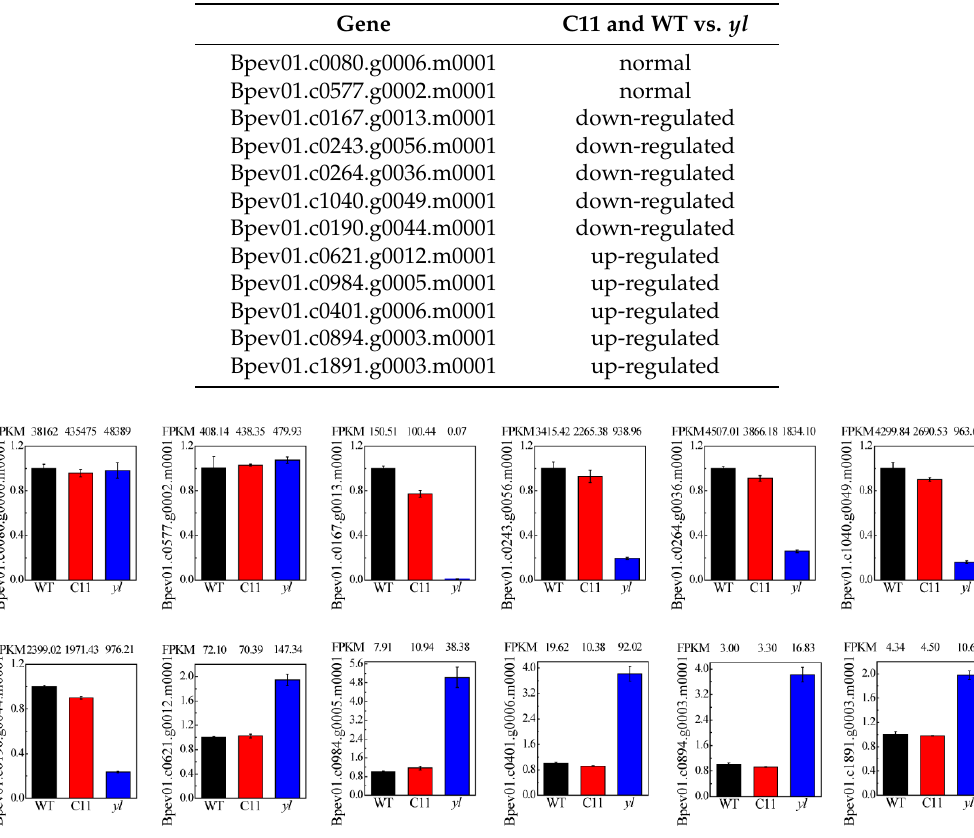
Figure 8. Quantificational real-time PCR verification of RNA-seq. Error bars represent the SD of three measurements. 289